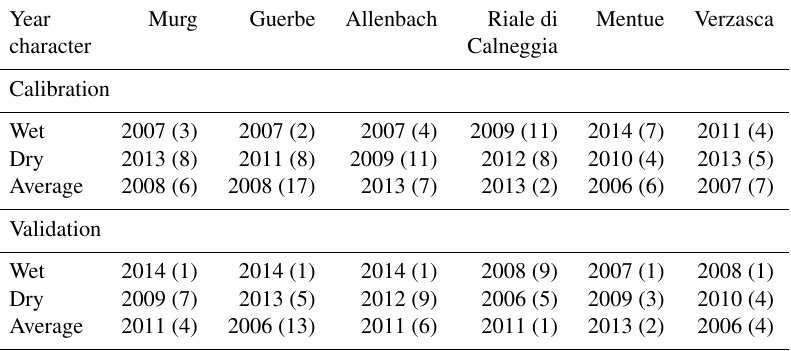
Table 2. The calibration years (second most extreme and second closest to average years) and validation years (most extreme and closest to average years) for each catchment. The numbers in parentheses are the ranks over the period 1974–2014 (or 1990–2014 for Verzasca).